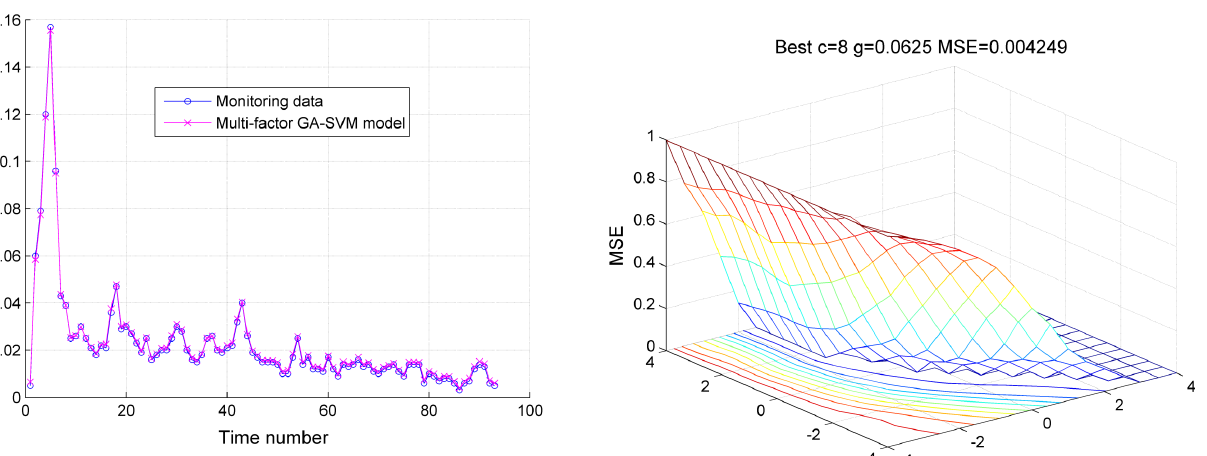
Fig. 9. The curves of the monitoring and predicting values of the displacement rate of the landslide with time.